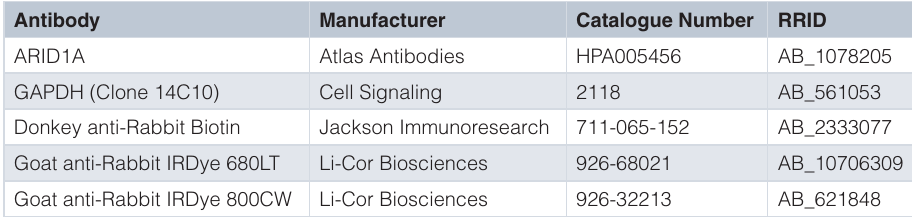
Table 2. Details of primary and secondary antibodies.